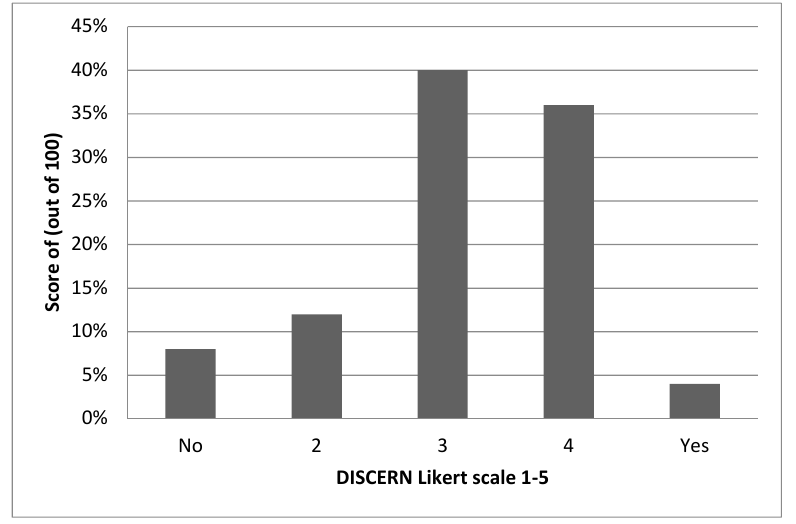
Figure 5. Evaluation of additional sources of information by LS.